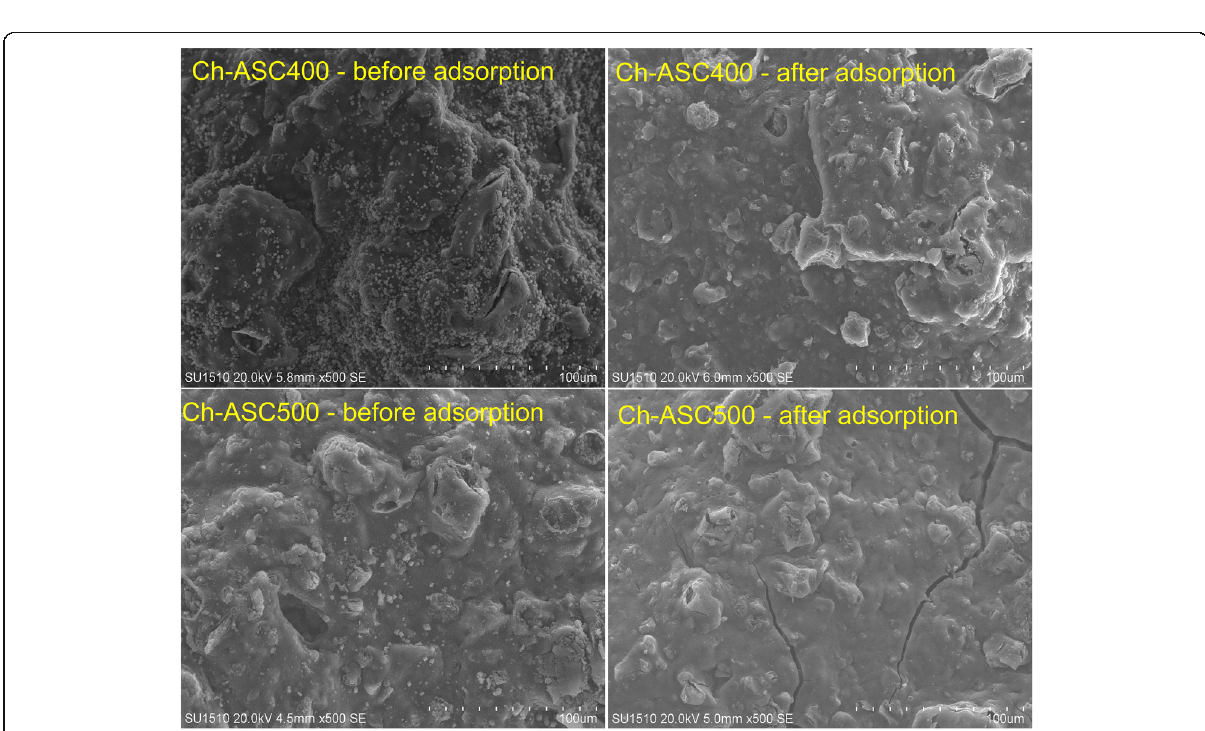
Fig. 4 SEM images of Ch-ASC400 and Ch-ASC500 before and after Cr(VI)